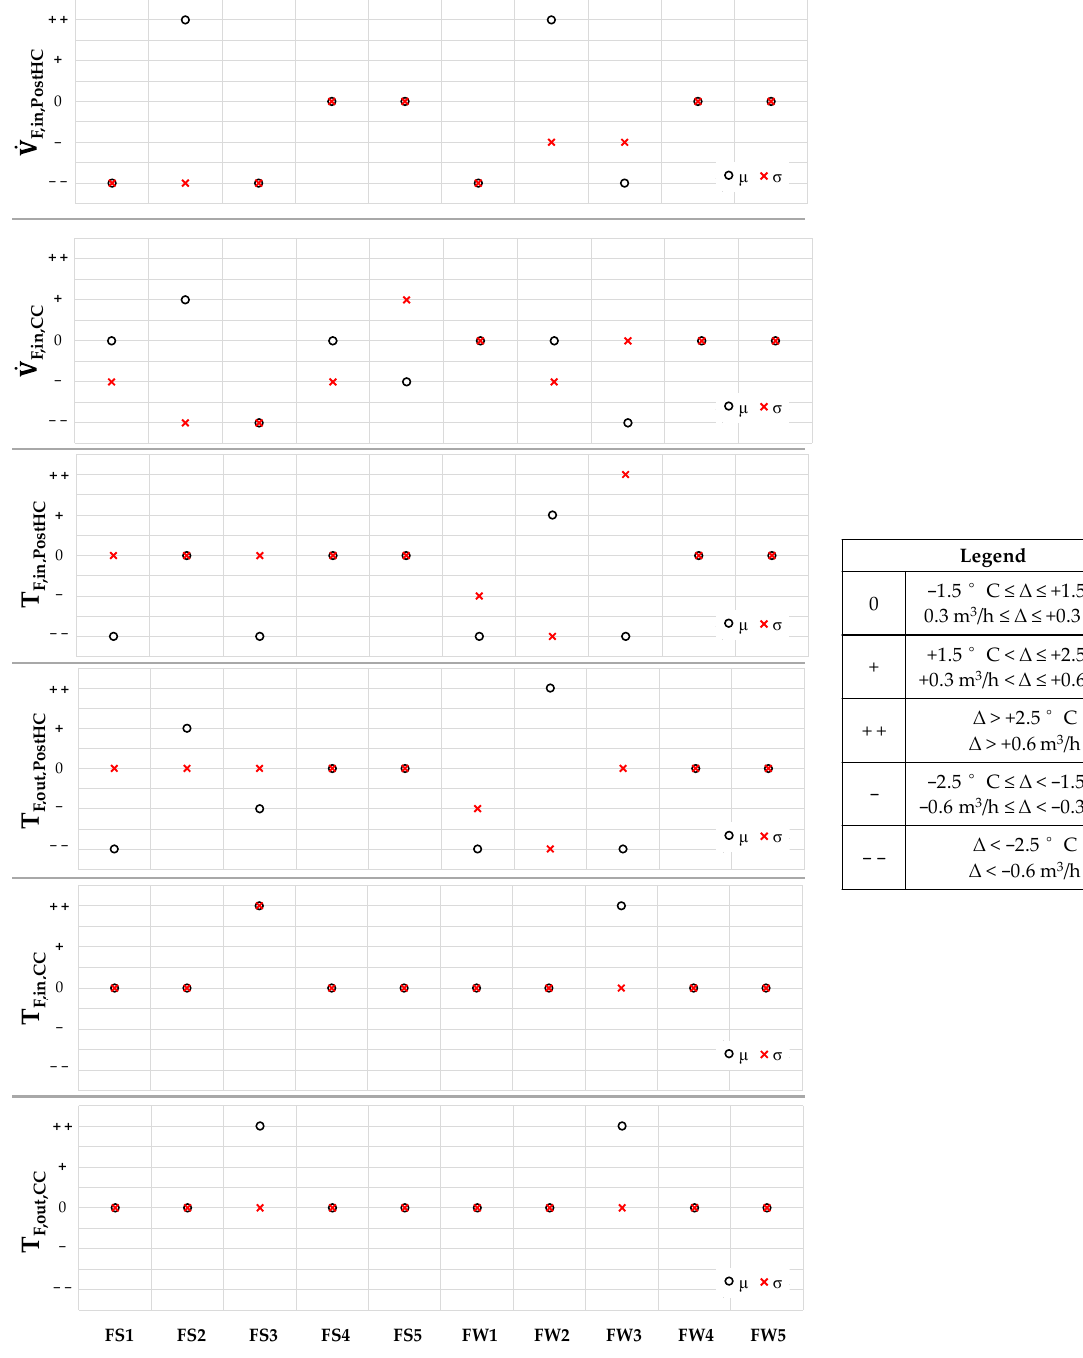
Figure 11. Symptoms’ relevance to the selected faults in terms of heat carrier fluid parameters.